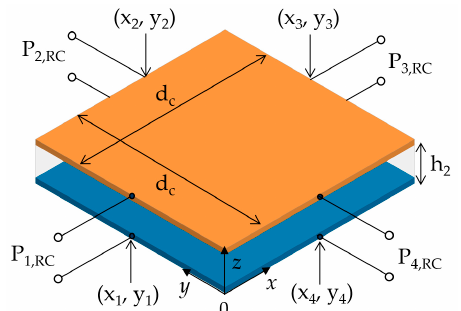
Figure 5. A resonant cavity model of the rectangular cavity for analytical UC modeling.